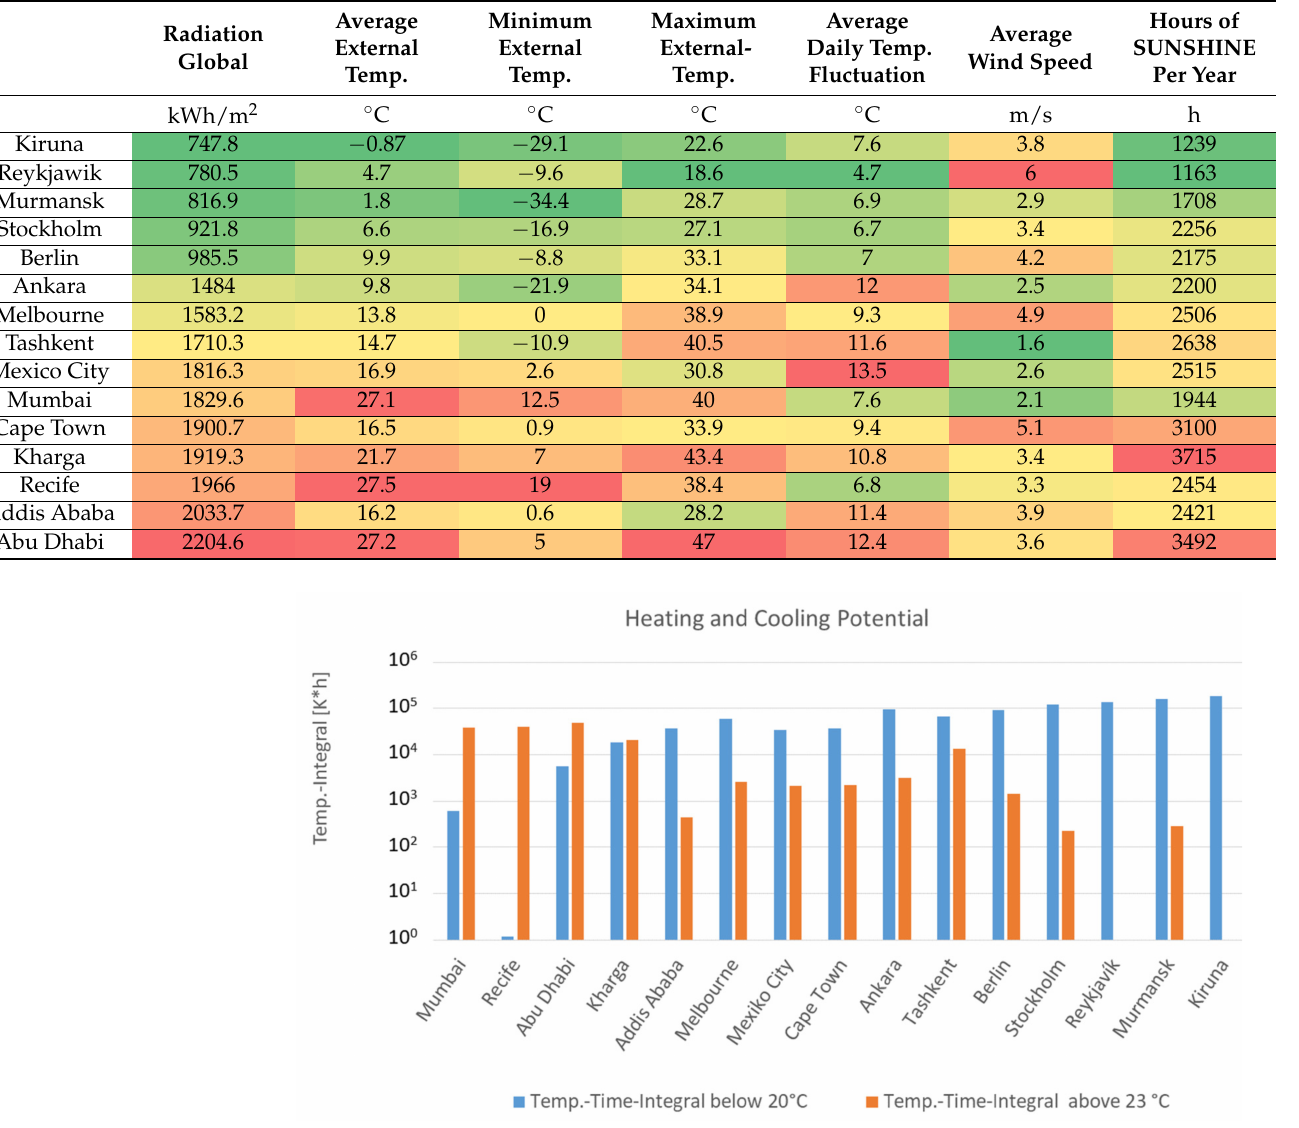
Figure 5. Annual temperature–time integrals for different cities. Temperatures above 23 ◦ C (cooling potential) and below 20 ◦ C (heating